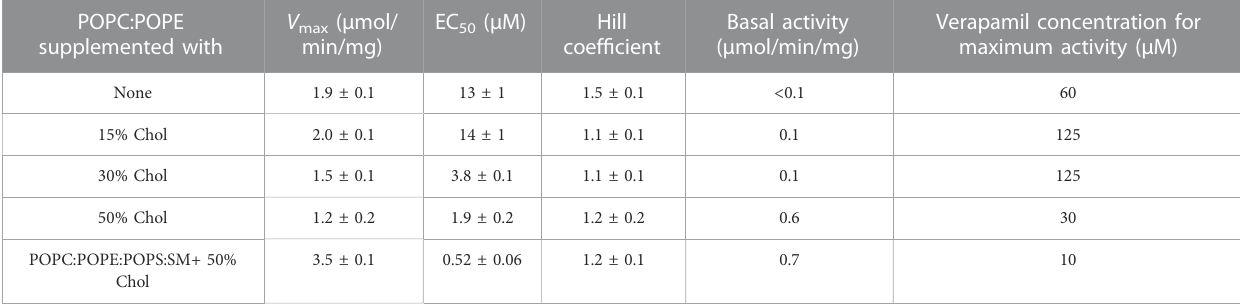
POPC:POPE:POPS:SM+ 50%